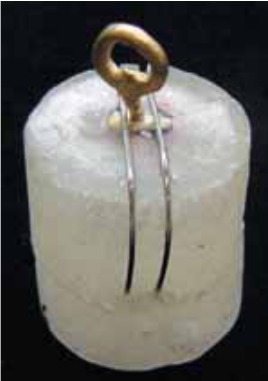
Figure 3- Application of ultrasonic vibration